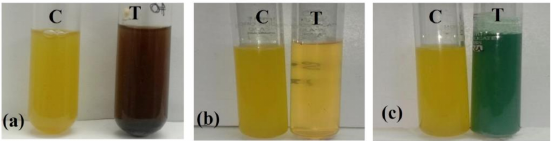
Figure 3. The synthesis of Nanoparticles using Lactiplantibacillus plantarum supernatant: ( a ) treated with silver nitrate solution which turned dark brown after 24 h, ( b ) treated with Sodium selenite which showed no color change after 48 h, ( c ) treated with Copper Sulphate which showed no color change after 24